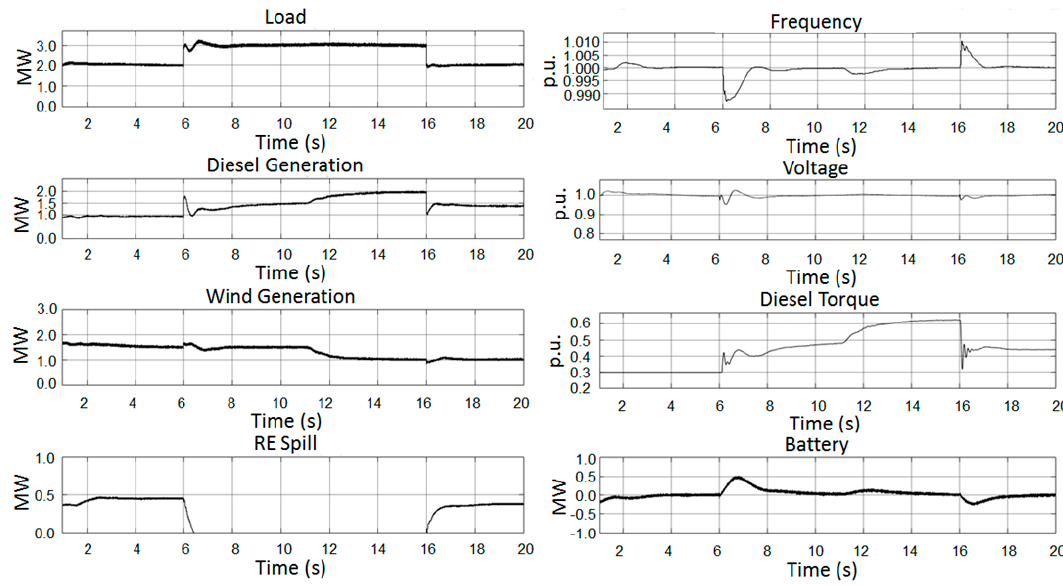
Figure 5. Operation of the diesel plus ESS system (Case 2) under wind speed deviation and 60% load perturbation, Top left going clockwise: Load (MW), Frequency (p.u.), Voltage (p.u.), Diesel Torque (p.u.), Battery (MW), Dump Load (MW), Wind Generation (MW), Diesel Generation(MW).